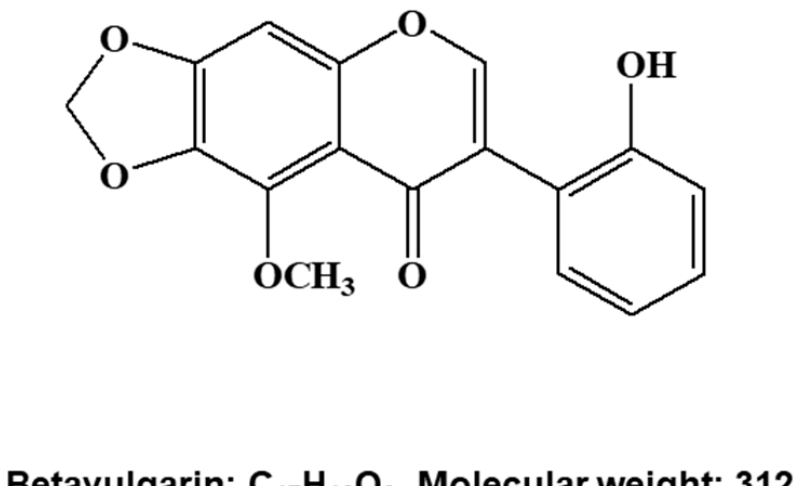
Figure 2. Molecular structure of the BCSC inhibitor isolated from beet extracts. Molecular structure of betavulgarin.